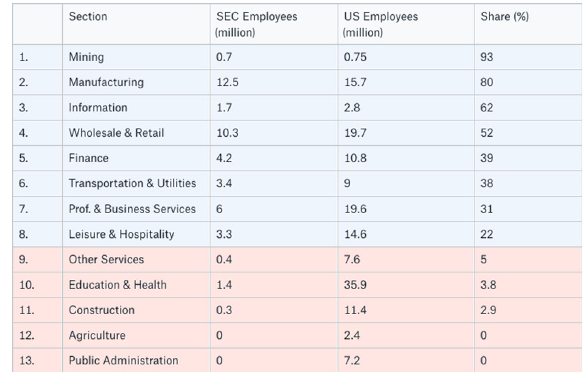
Fig. 7 Number of employees working in different sectors of the US economy and share of employees working in fi rms that report to the SEC. In eight out of 13 sectors, the fi rms that fi le to SEC represent at least 22% of all employees in that